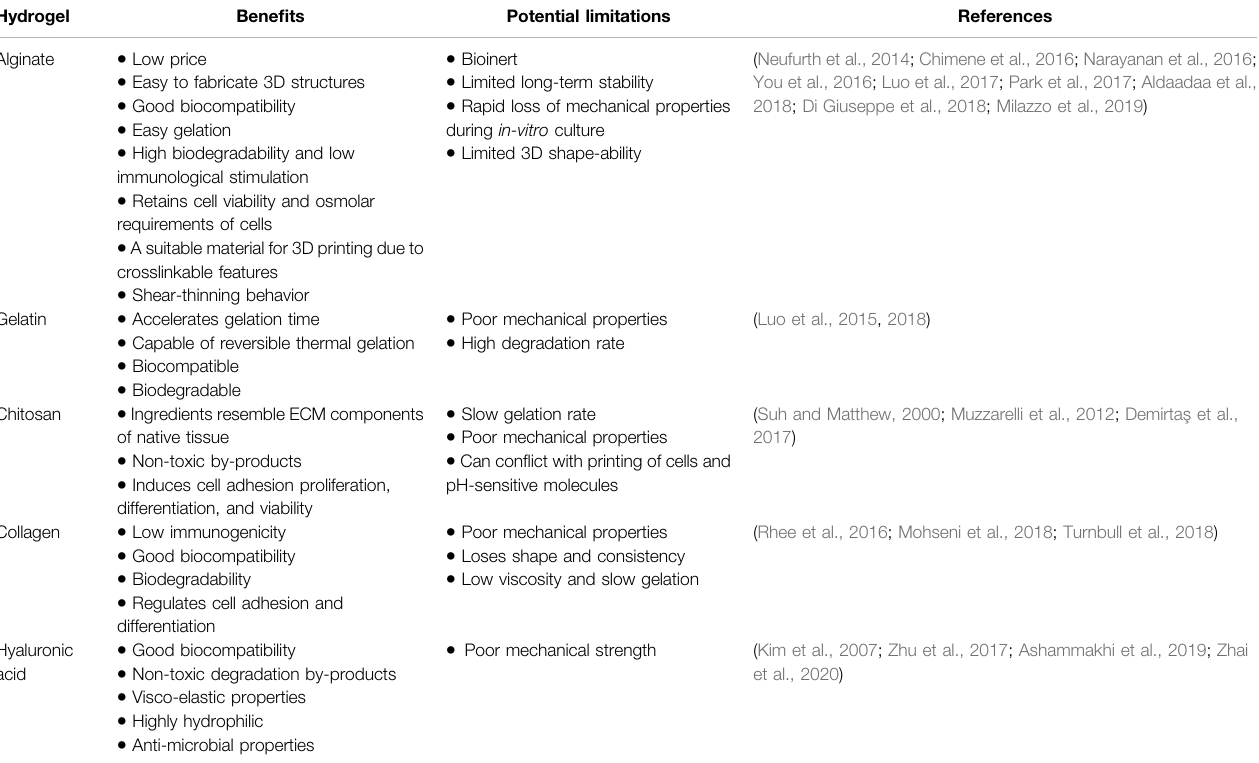
TABLE 1 | Bene fi ts and potential limitations of natural hydrogels commonly used in bioprinted bone scaffolds. Hydrogel Bene fi